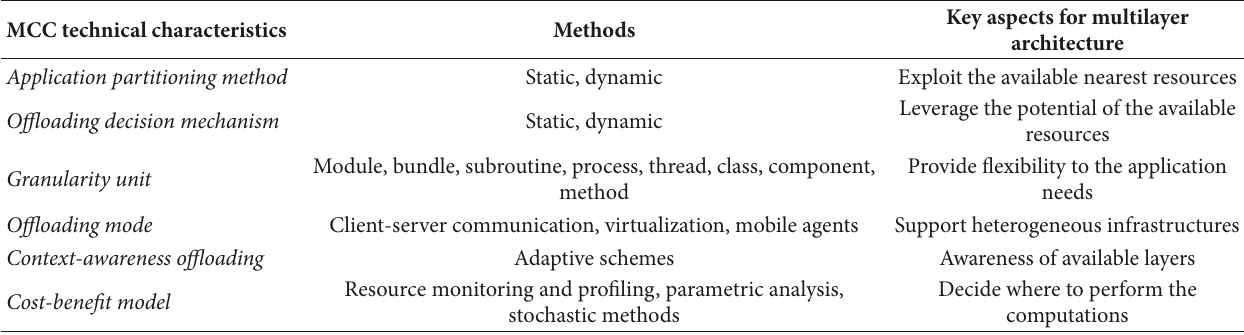
Table 2: Technical characteristics of offloading methods and